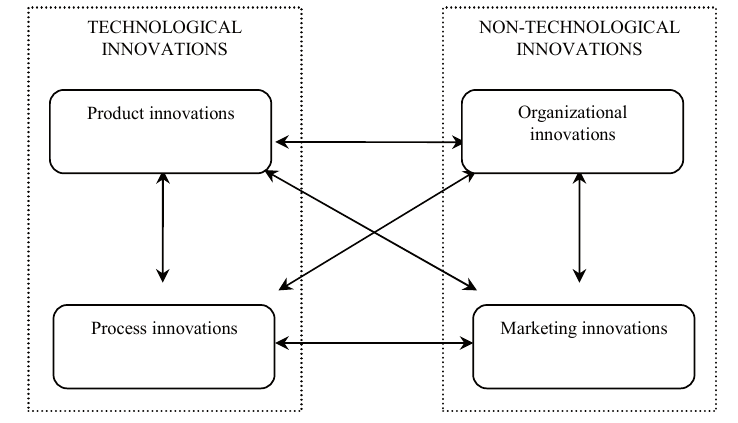
Fig. 1 – Types of innovations and occurring interdependencies (Source: Bigliardi & Dormino,